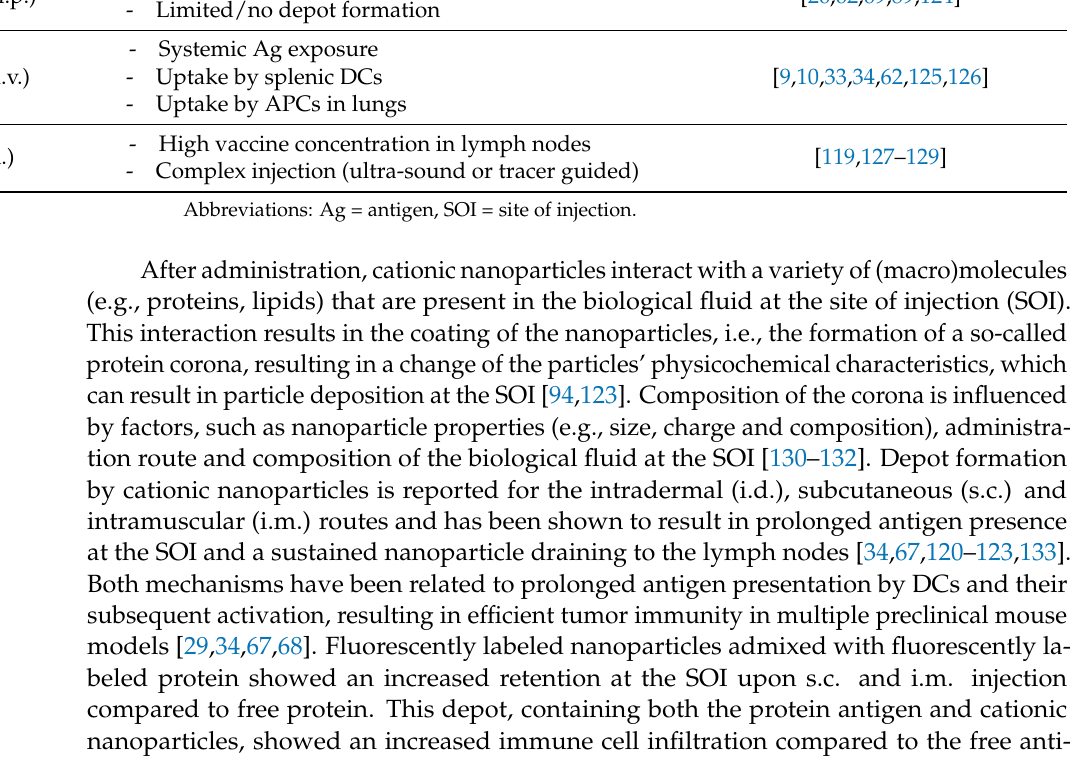
Abbreviations: Ag = antigen, SOI = site of